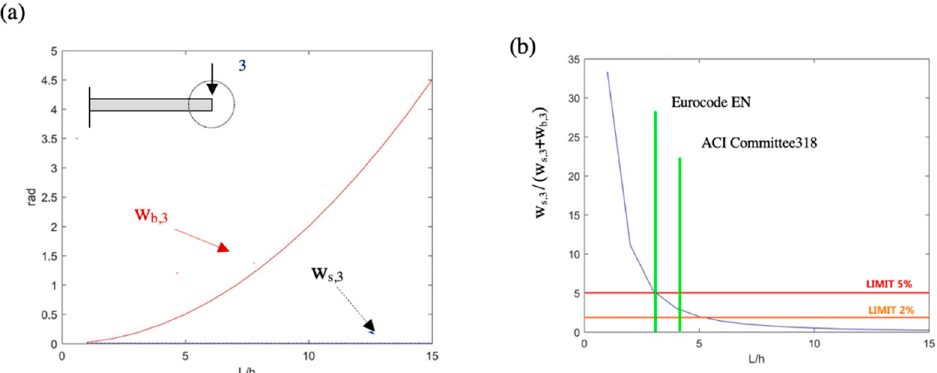
Figure 8. Parametric analysis of the effect of the slenderness ratio on a cantilever beam with a concentrated load: ( a ) bending ( w b ,3 ) and shear ( w s ,3 ) rotations at node 3 and ( b ) percentage error of rotations in node 3 when ws,3 was neglected.